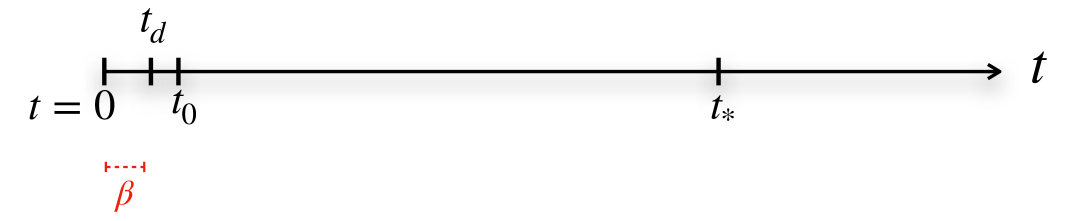
Figure 1 . Three time scales that are important for chaos are shown here schematically for thermal quantum systems with a large number of degrees of freedom and a simple Hamiltonian which is sufficiently local. These time scales are: t t ∗ = scrambling